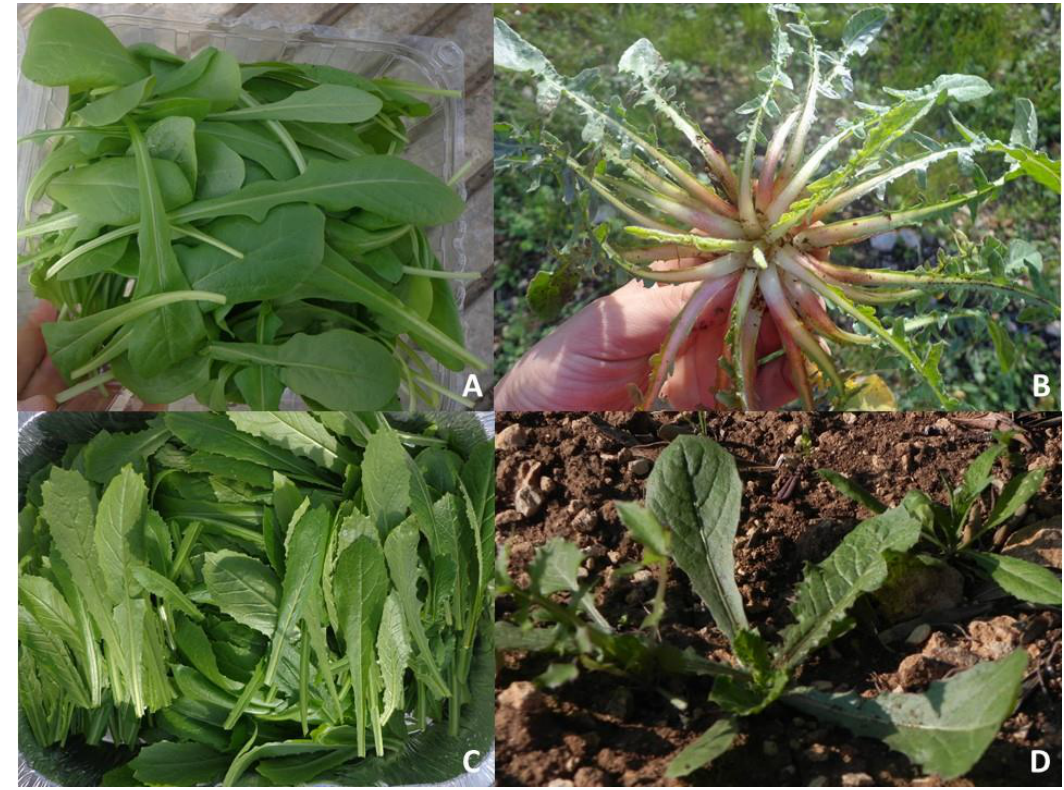
Figure 2. U. delechampii grown by using a floating system ( A ) and in grasslands ( B ); U. picroides grown by using a floating system ( C ) and in grasslands ( D ).